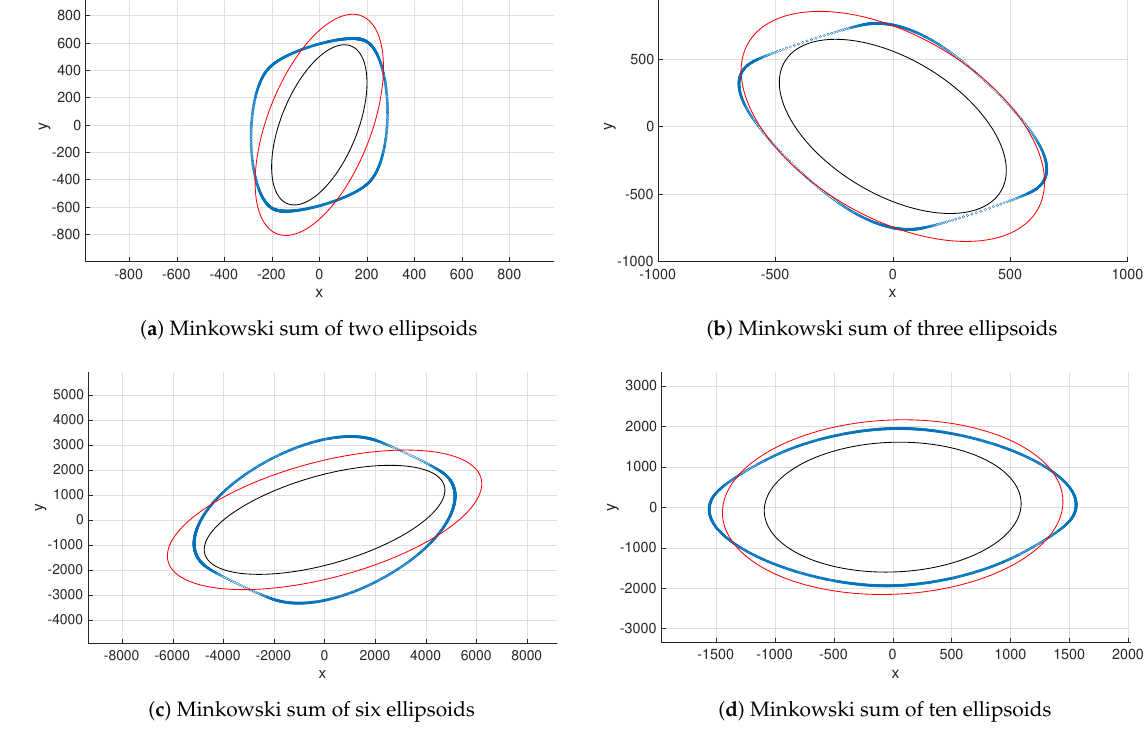
Figure 2. Two ellipsoidal approximations of Minkowski sums of two, three, six and ten numbers of ellipsoids. The blue dotted curves represent the actual Minkowski sums, the black curves are ellipsoidal approximations (14) for µ = 0 and the red curves are ellipsoidal approximations (15) for n = 2 and µ = 0 .